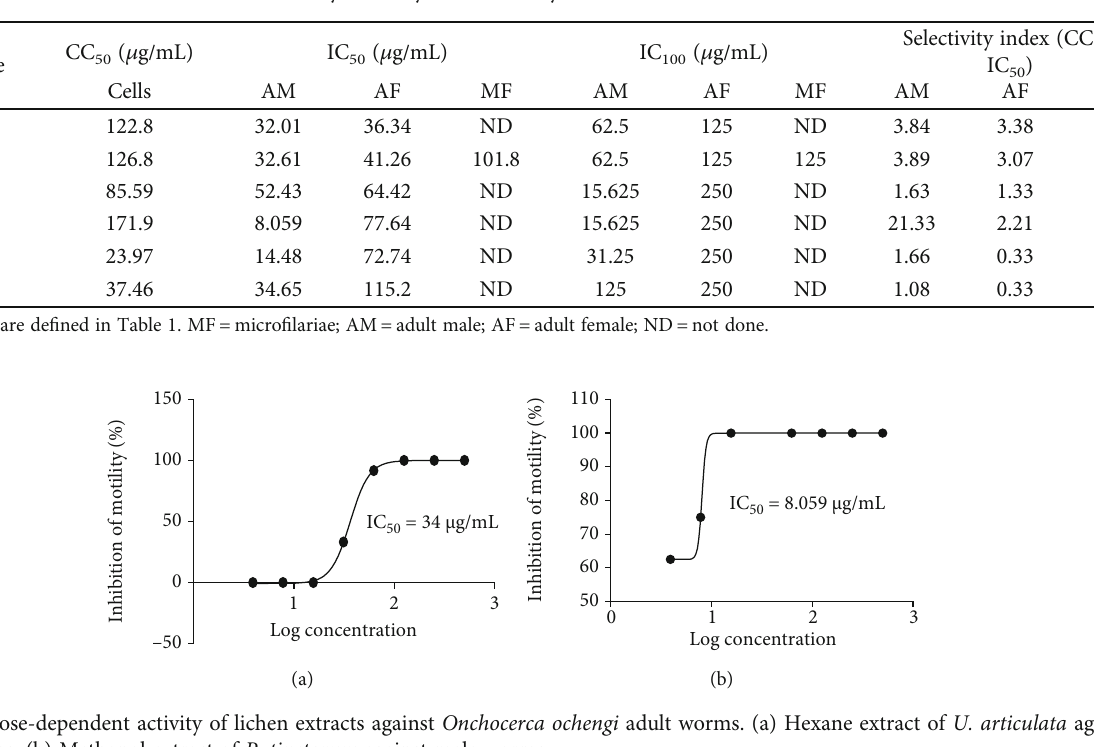
Table 2: Cytotoxicity and selectivity indices of lichen